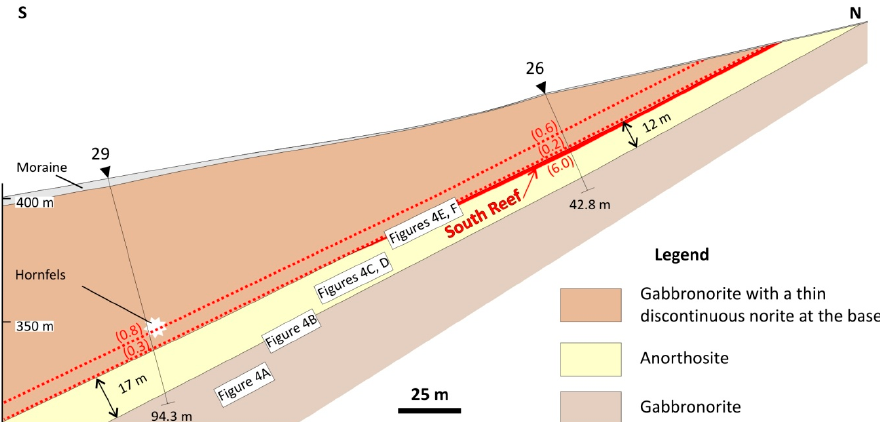
Figure 3. Simplified cross-section of the Main Anorthosite Layer from the West-Pana intrusion based on internal data from JSC Pana. The South Reef is shown as a solid red line, whereas PGE mineralization is indicated by red dotted lines. Note that the hornfels-hosted PGE mineralization (Borehole 29) is traced up-dip in the inequigranular gabbronorites (Borehole 26). Maximum Pd concentrations in drill core samples are shown in parentheses. Minerals 2019 , 9 , x FOR PEER REVIEW